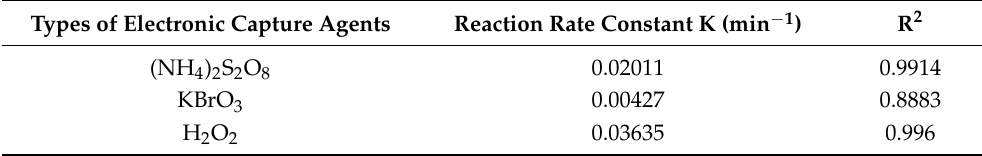
Table 1. Reaction rate constants for different types of electron capture agents.